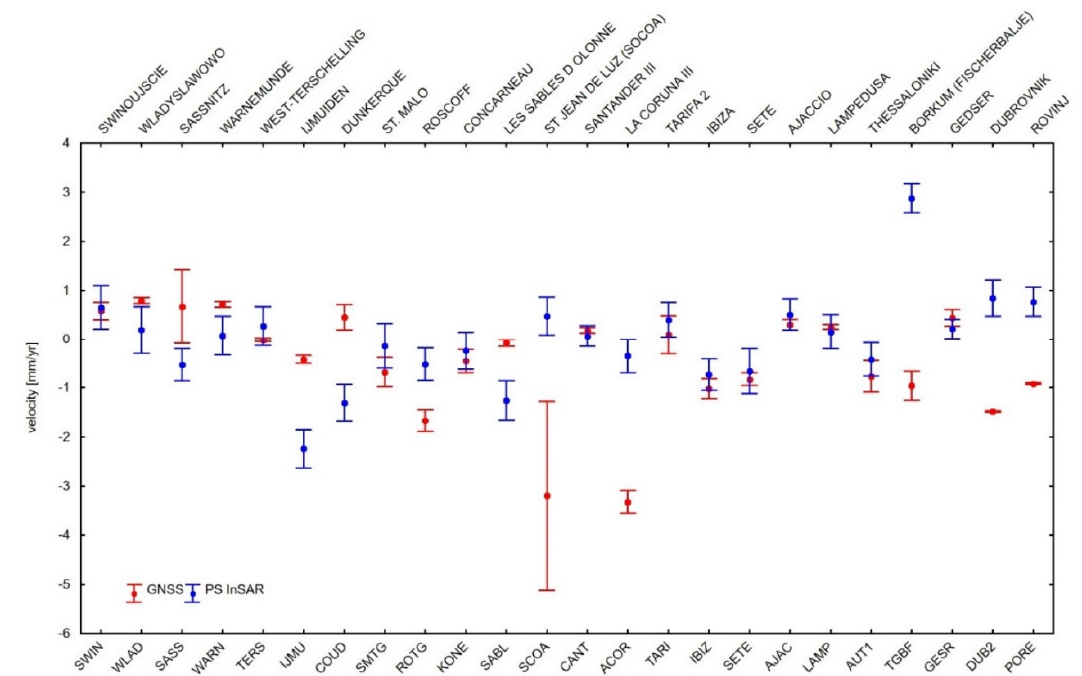
Figure 16. Vertical crust movements in TG sites along the European coast derived from PSInSAR data and the corresponding GNSS data.